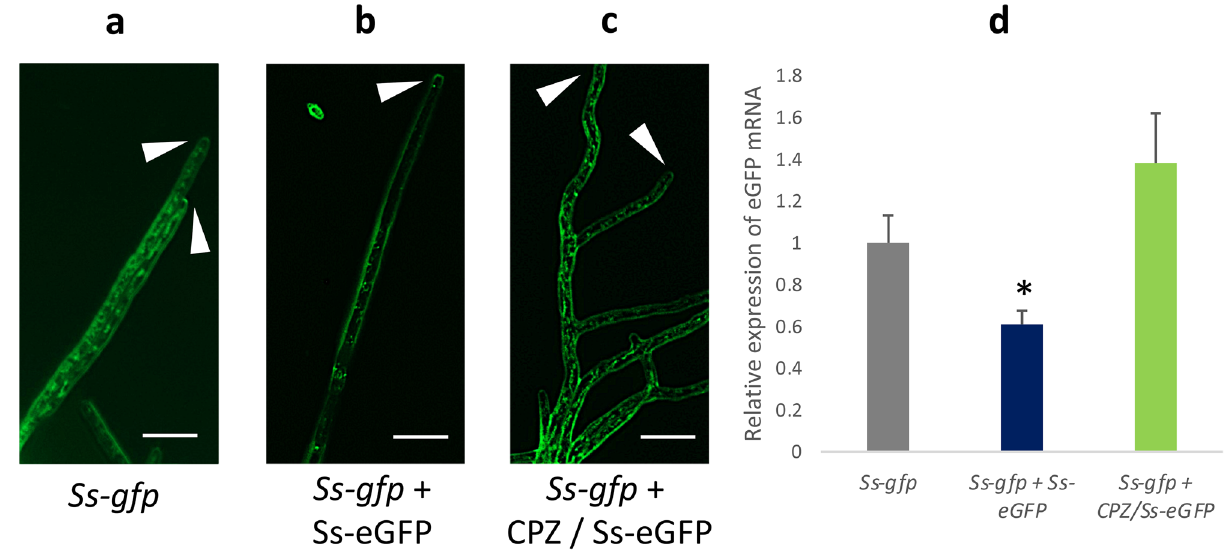
Figure 4. EGFP-transgenic Sclerotinia show reduced fluorescence when treated with dsRNA targeting eGFP, but not when first treated with chlorpromazine (CPZ). In vitro cultures of the eGFP-Sclerotinia were treated with 1,000 ng/mL of dsRNA targeting eGFP with or without 20 µM CPZ. After four days, hyphae were imaged. ( a ) Untreated eGFP-Sclerotinia showing normal fluorescence (White arrows with no border: hyphal tips) ( b